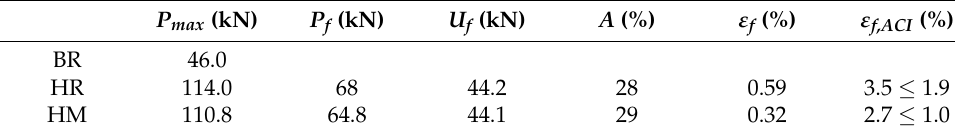
Table 10. Analytical estimation of the strain reached by the fabrics, ε f